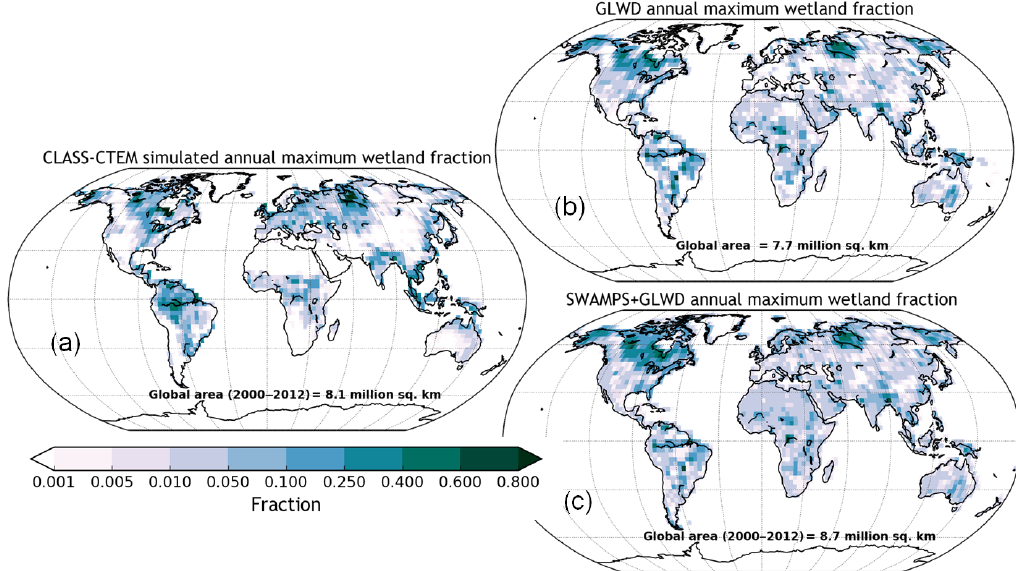
Figure 7. Comparison of geographical distribution simulated annual maximum wetland fraction with observation-based estimates based on the Global Lakes and Wetland (GLWD; Lehner and Döll, 2004) and a new product that is formed by merging remote sensing based observations of daily surface inundation from the Surface Water Microwave Product Series (SWAMPS; Schroeder et al., 2015) with the static inventory of wetland area from the GLWD as explained in Poulter et al. (2017).